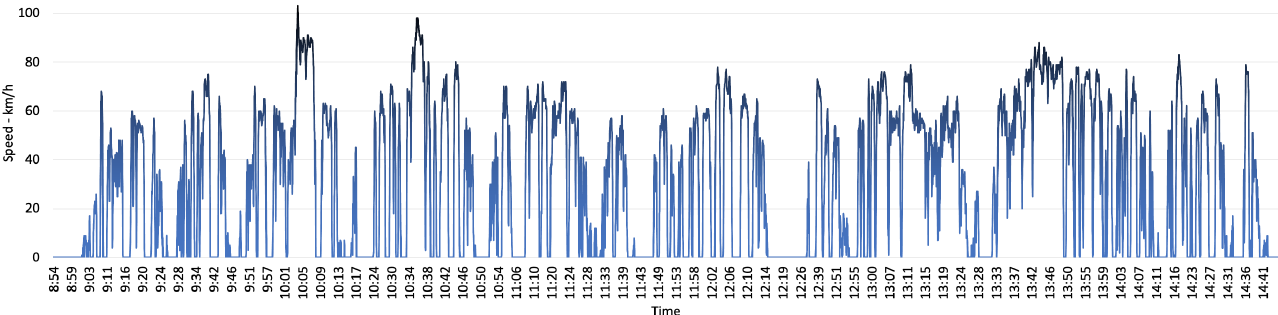
Figure 9. Vehicle’s speed data collected during the field-trial.